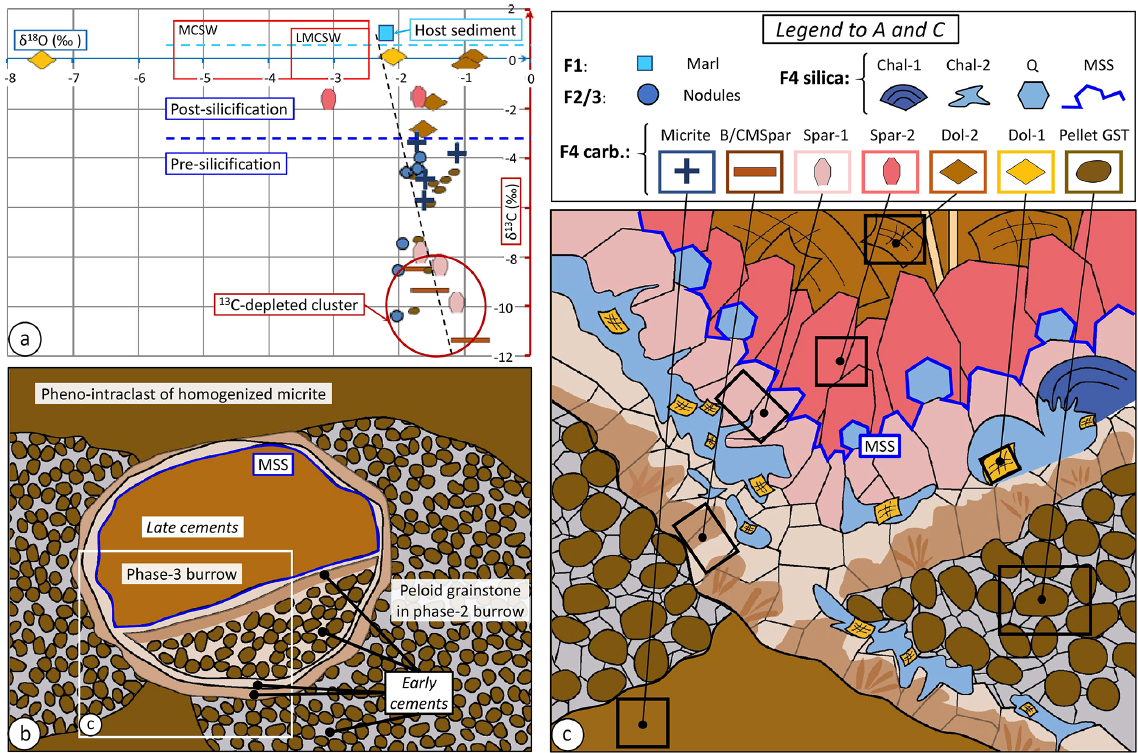
Figure 13. Stable C and O isotopes and microfacies. (a) Sedimentary and diagenetic carbonate phases encountered in the Aurel pseudobio- herm in δ 13 C– δ 18 O plot; the position of samples of facies F1 to F3 is shown in Fig. 14. MCSW: middle-Callovian seawater composition; LMCSW: subset for the lower part of the middle Callovian (Pellenard et al., 2014). (b) Fabric and microfacies of F4 recording succes- sive phases of bioturbation; the white box indicates the general position of (c) . (c) Schematic geometric relationships between sediment and various cement generations within Facies F4; black boxes mark minimum size of samples drilled for isotope analysis, some likely mixing dif- ferent phases like peloid grainstone and BMSpar/CMSpar. GST: grainstone. Chal-1: early botryoidal chalcedony; Chal-2: later replacement chalcedony; Q: euhedral quartz crystals; MSS: main silicification surface; BMSpar and CMSpar: brown and clear microsparite, respectively; Spar-1: pre-silicification sparite; Spar-2: post-silicification sparite; Dol-1: syn-silicification saddle dolomite; Dol-2: late saddle dolomite; GST: grainstone. For details, see the